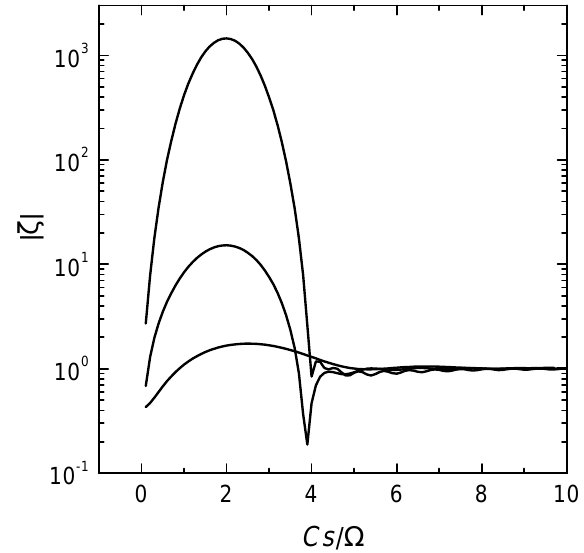
FIG. 7. Dependences of the (dimensionless) amplitude j z j on the time ( (cid:67)(cid:115) (cid:121) V ). From top to bottom at (cid:67)(cid:115) (cid:121) V (cid:173) (cid:50) , (cid:120) (cid:173) (cid:49)(cid:48) , 5, and 2. FIG. 8. Dependences of the relative deviation ( D